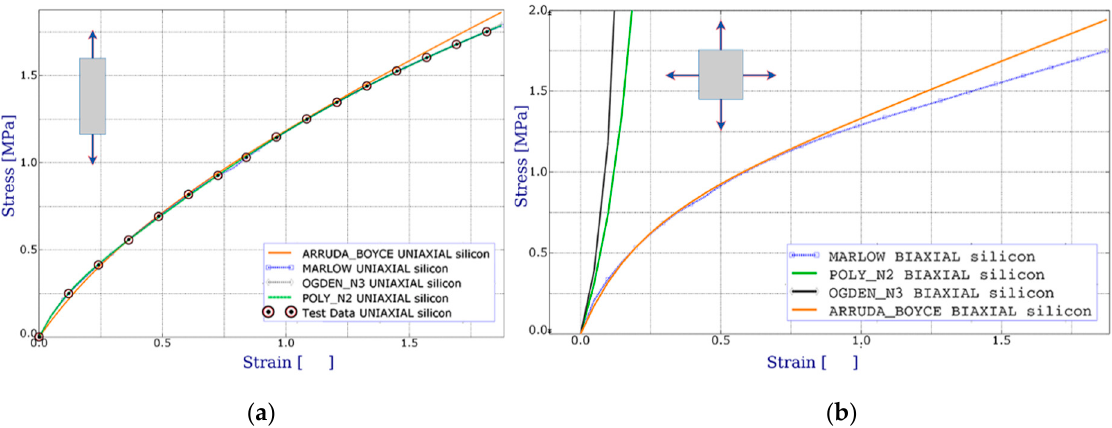
Figure 13. Comparison of the test data and various hyperelastic models. Stress–strain curves for tension test: ( a ) uniaxial; ( b ) biaxial.